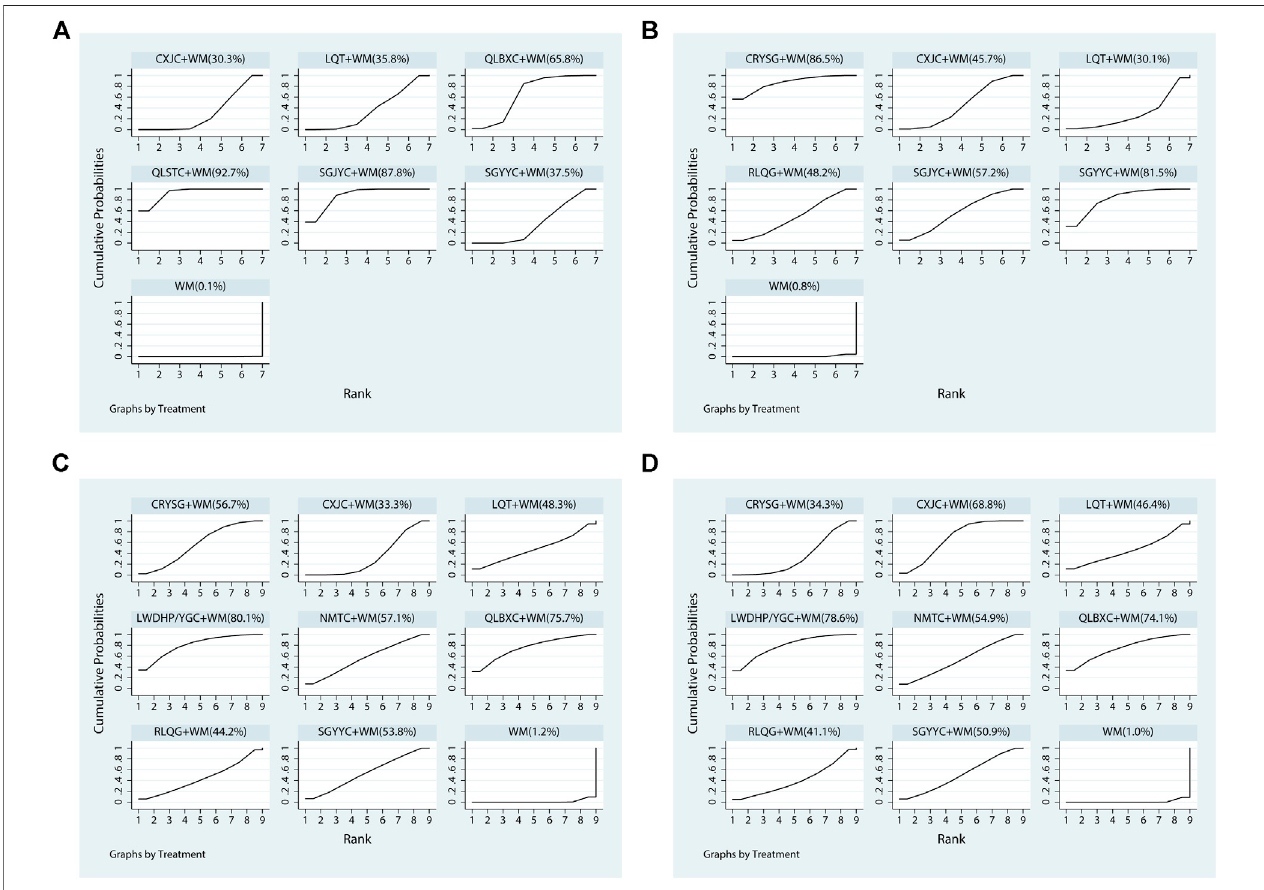
FIGURE 6 | Plots of the surface under the cumulative ranking curves for all treatments (A) NIH-CPSI; (B) IIEF-5; (C) the clinical effective rate of CP/CPPS; (D) the clinical effective rate of SD.